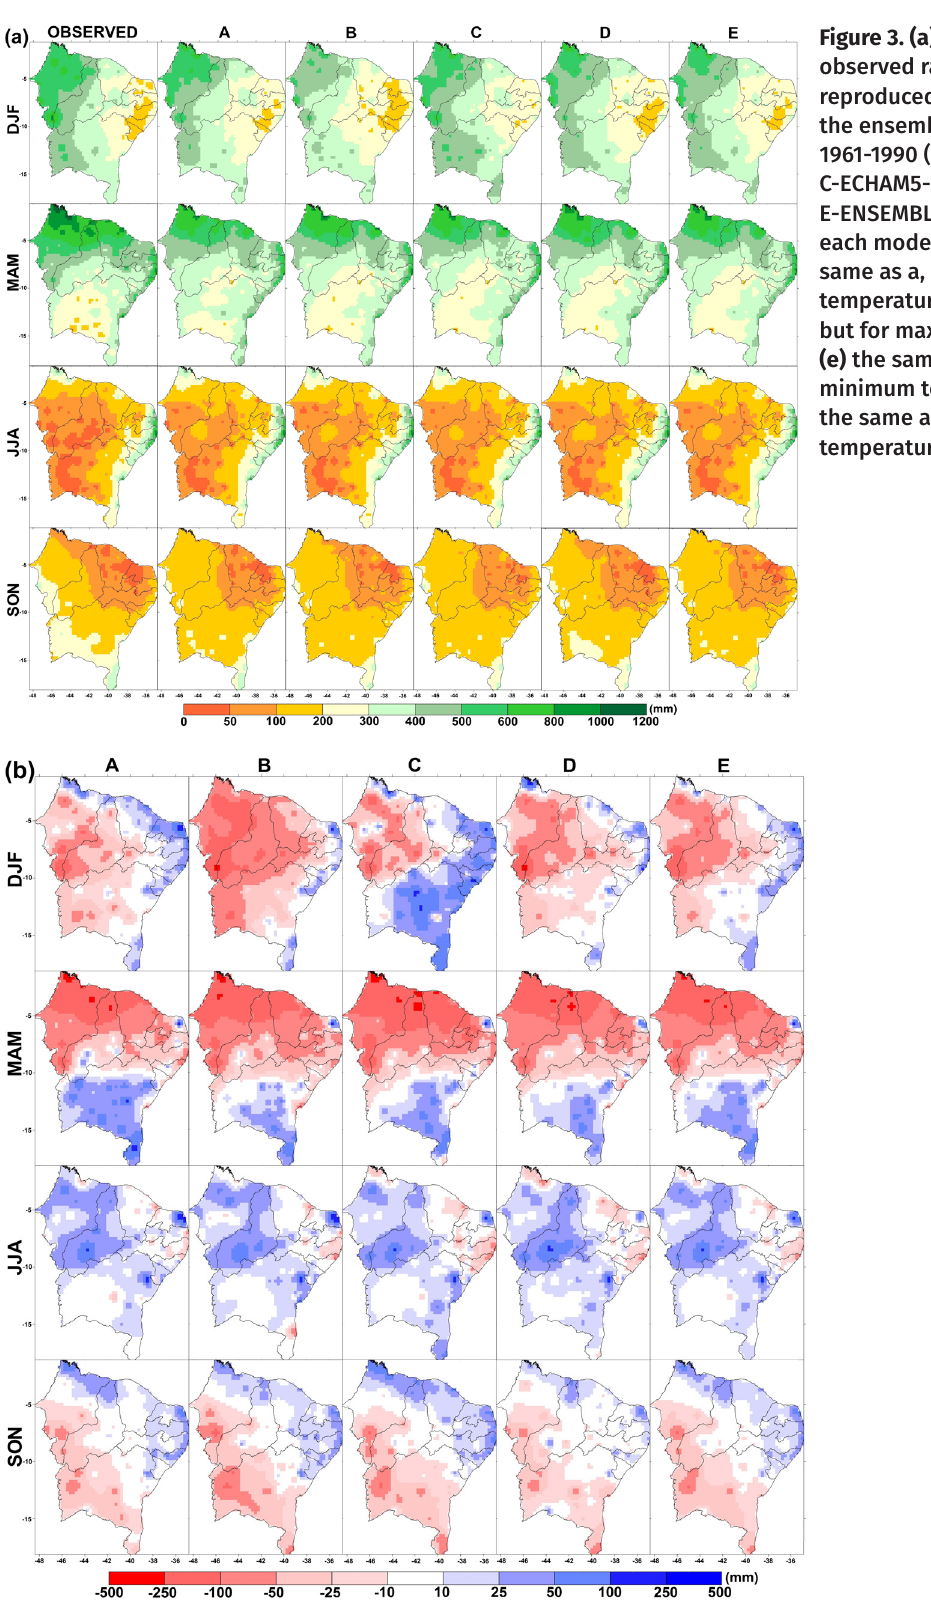
Figure 3. (a) Seasonal means of observed rainfall and the ones reproduced by each model and the ensemble for the period 1961-1990 (A-BCM2, B-CNRMCM3, C-ECHAM5-OM, D-HadGEM2-ES, E-ENSEMBLE), (b) deviations of each model for rainfall, (c) the same as a, but for maximum temperatures, (d) the same as b, but for maximum temperatures, (e) the same as a, but for minimum temperatures and (f) the same as b, but for minimum